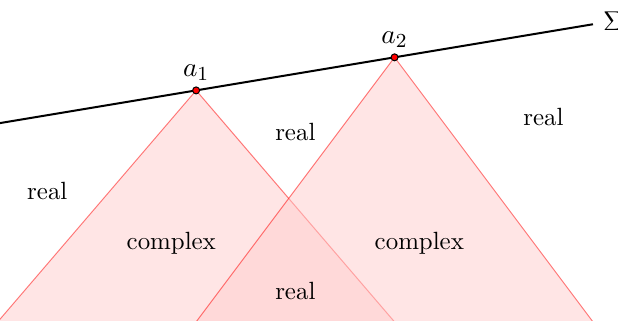
Figure 5 . Causal domains on the boundary ket spacetime B k for a two dimensional field theory with the region A taken to be a spacelike segment of a boosted Cauchy slice. We indicate the regions where the resulting metric is real and complex, respectively. In general the metric is not guaranteed to be real in regions that are in the causal past of the entangling surface ∂ A which here comprises of the two points a and a 1 2